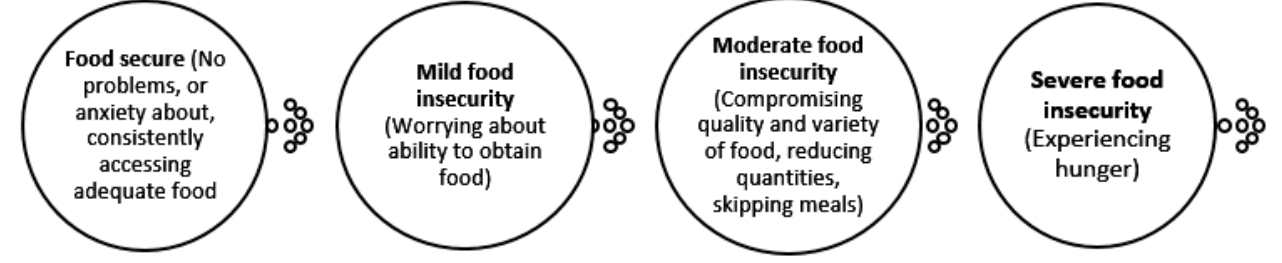
Figure 3. Household food insecurity classifications (HFIAP). Source: Adapted from Coates et al.